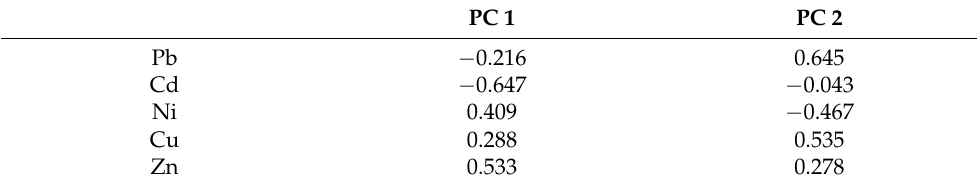
Table 6. Principal component analysis for the